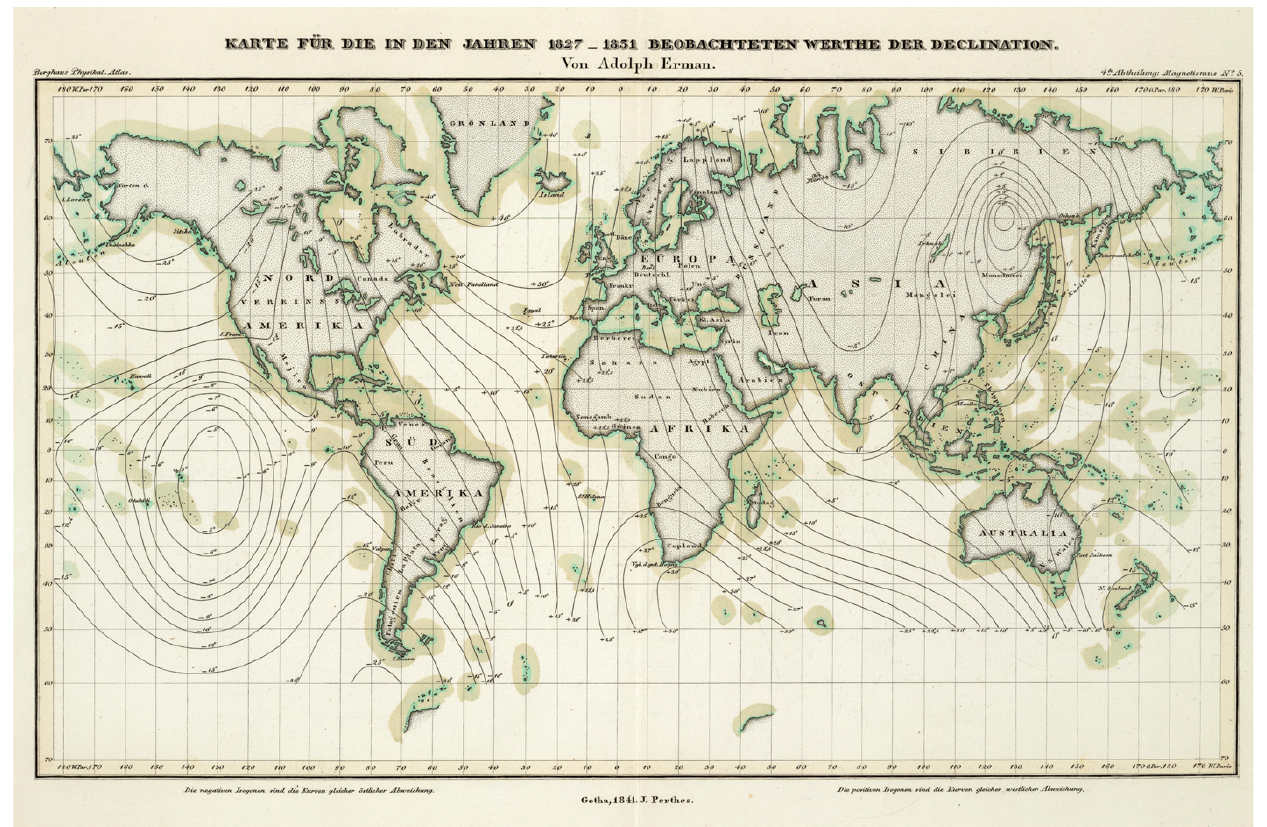
Figure 5. World map of magnetic declination measured from 1827 to 1831 published in Gotha in 1841 (Berghaus, 1837–1848) (David Rumsey Map Collection, www.davidrumsey.com, USA; Images copyright © 2000 by Cartography